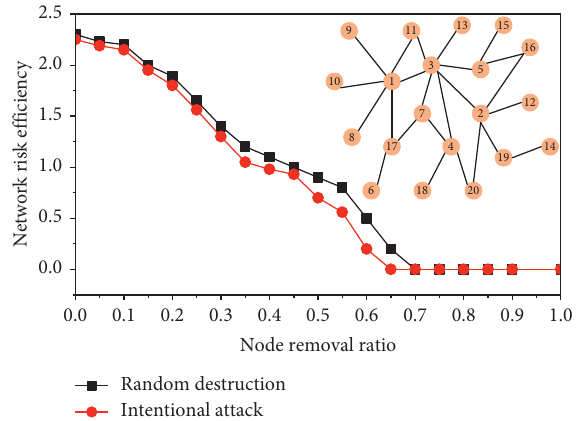
Figure 6: Changes of risk efficiency of cross-border e-commerce logistics network under different node attack strategies.